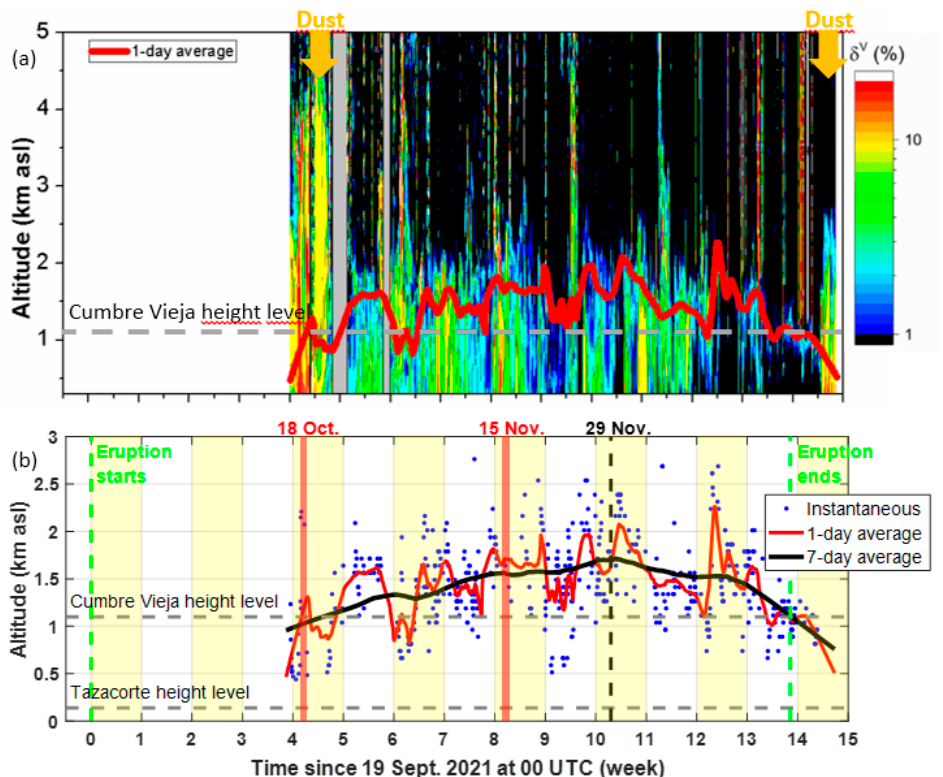
Figure 2. ( a ) Time–height plot of the volume depolarization ratio, δ V , and ( b ) temporal evolution of the peak height of the lowermost volcanic plume, h P . The green dashed vertical lines indicate the start and end of the eruption. The black dashed vertical line indicates the gradient switch of the 7-day average from positive to negative. The two red-shaded areas indicate the days discussed in Section